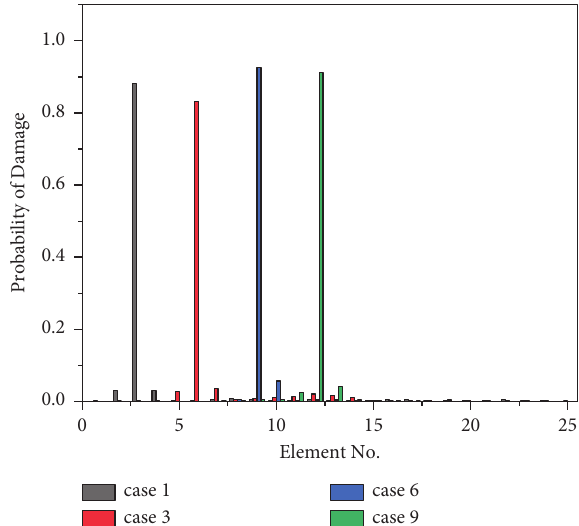
Figure 12: Recognition results of second-level fusion for single damage.